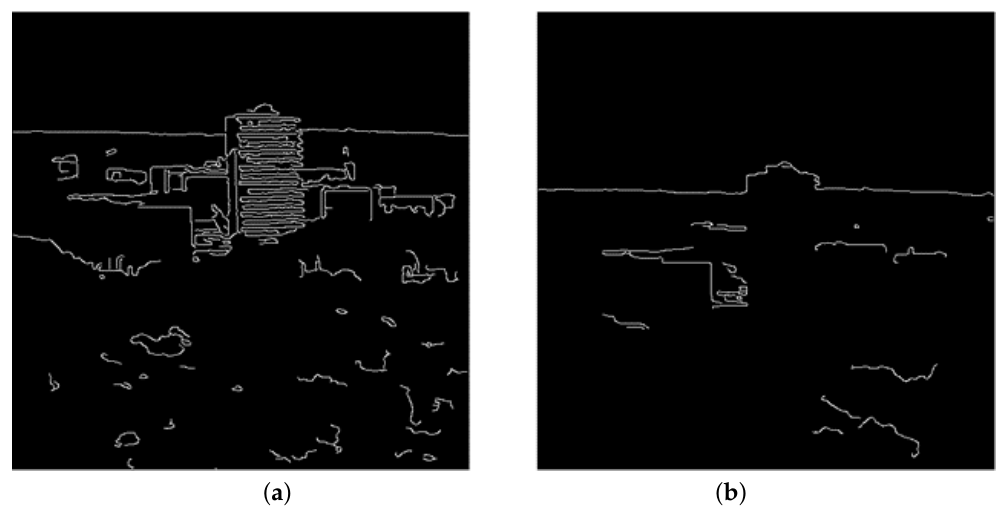
Figure 4. Separation of area contours with a Canny filter with a threshold value of 0.45, when ( a ) the sun is shining, ( b ) overcast.